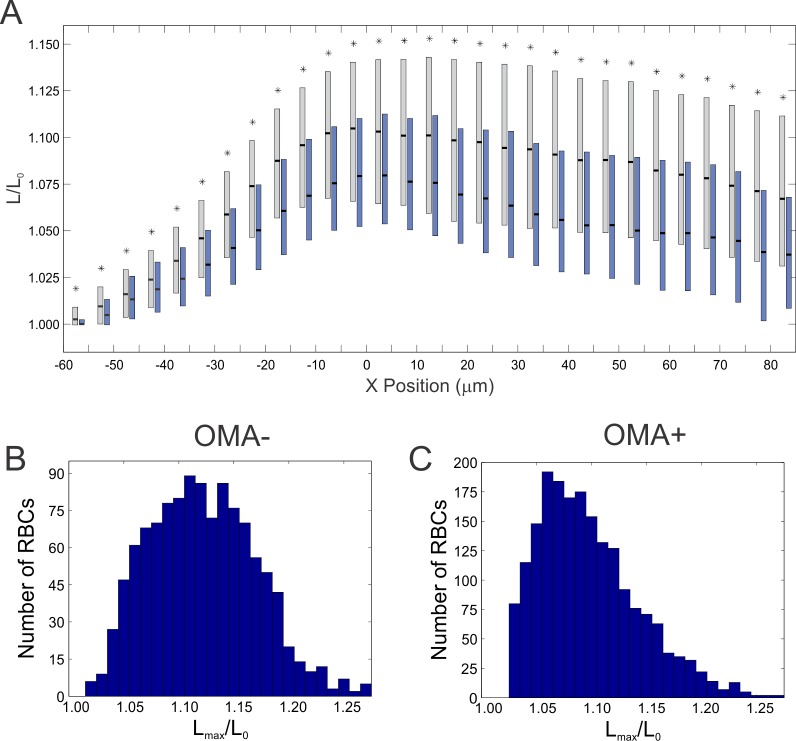
(A) Box plot of the ratio of the instantaneous length stretched (L) to initial length (L0) as a function of X position in the channel (OMA- = gray boxes, OMA+ = blue boxes). Distributions represent entire population of RBCs examined, from all participants. The top and bottom of the rectangles represent the 25th and 75th quartiles, the thick black bars indicate the median. Bin widths were 5 μm; the boxes for OMA- and OMA+ are staggered within each bin for clarity. Asterisks (*) indicate distributions with p<0.05 compared to the control (OMA-). (B,C) Histograms for the maximum length stretched, Lmax/L0, for (B) OMA- RBCs and (C) OMA+ RBCs, fasting samples only. Note the distribution is shifted to the left (lower Lmax) for OMA+ RBCs. The total number of cells observed: nOMA- = 1156, nOMA+ = 1955.